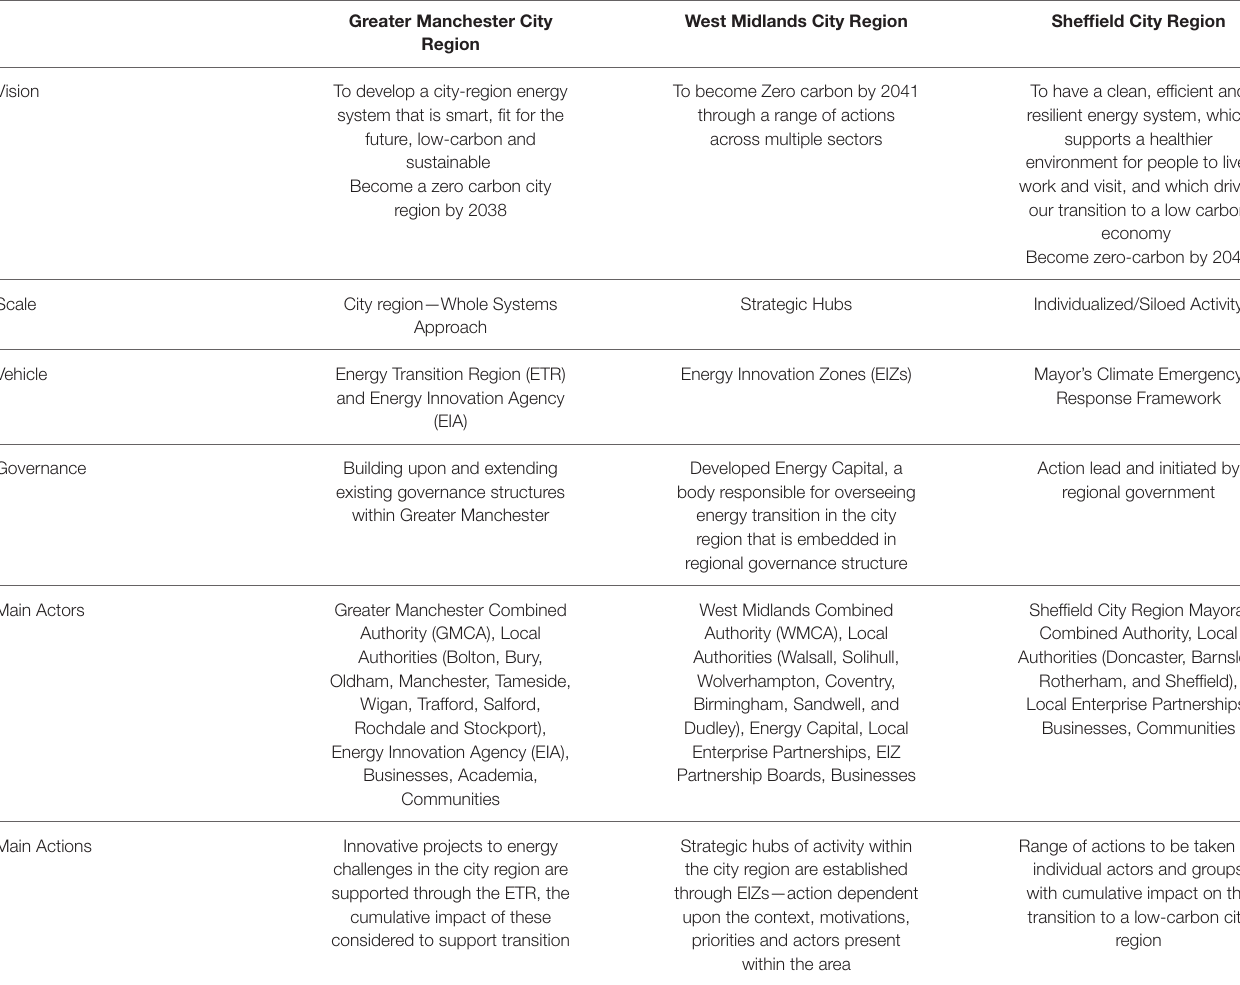
TABLE 2 | A table outlining the approaches developed by each of the city regions, summarizing the overarching vision, the scale of action, the governance structure and key